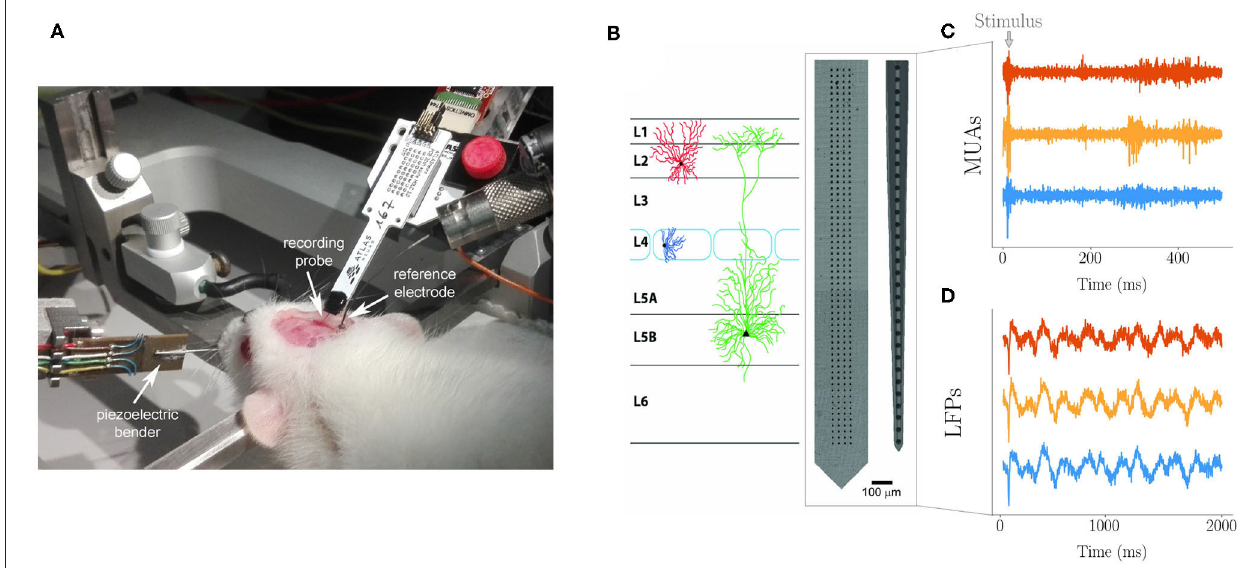
FIGURE 1 | (A) Experimental setting for recording with the anesthetized rat immobilized on the stereotaxic apparatus. The Atlas probe for spikes and MUAs recording is inserted in the barrel cortex through the dedicated cranial window. The cortical surface is bathed by Krebs’ solution that is grounded through the immersed Ag/AgCl reference electrode. The piezoelectric bender with cannula used to control single whisker deflection is visible on the left. An identical arrangement, but with the custom high-density probe, was adopted for LFPs recording. (B) Custom 2D 64 × 4 array used for LFPs and commercial 1D array used for MUAs spanning across cortical layers as during recording (schematic drawing). The actual number of electrodes spanning the barrel cortex was 220 for LFPs (organized in a 55 × 4 matrix form) and 27 for MUAs, with the other electrodes of the arrays remaining above the cortical surface bathed by the grounded electrolyte. Examples of MUAs (C) and LFPs (D) traces (from three representative channels